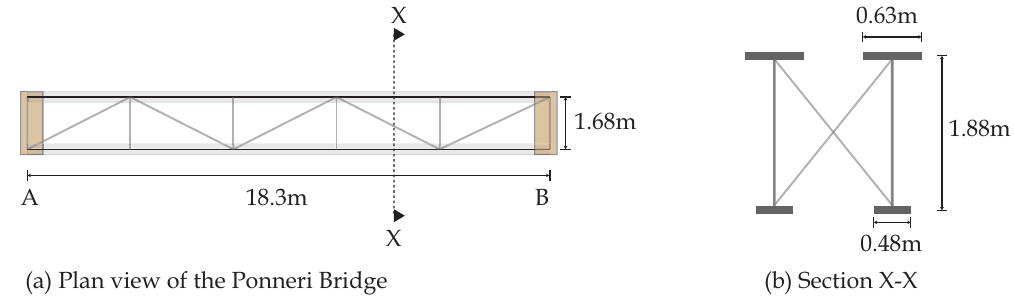
Figure 3. ( a ) Plan view of the bridge; and ( b ) section X-X showing details of the two steel girders.